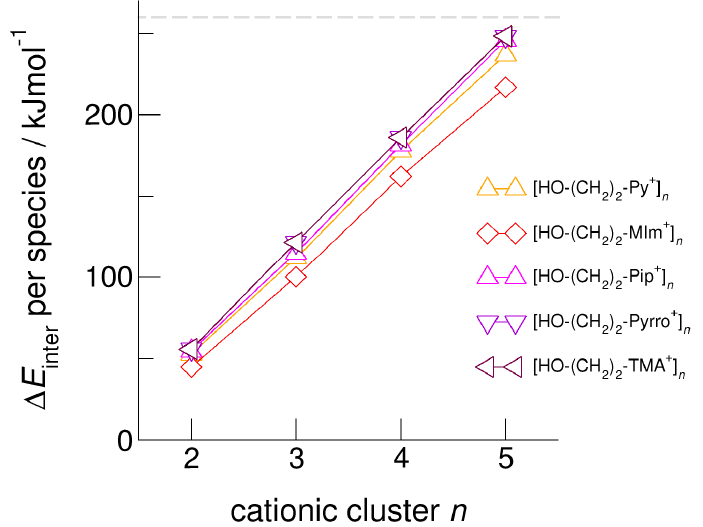
Figure 5. Intermolecular energies per species in the cationic clusters [HO-(CH 2 ) 2 -Py + ] n , [HO-(CH 2 ) 2 -MIm + ] n , [HO-(CH 2 ) 2 -Pip + ] n , [HO-(CH 2 ) 2 -Pyrro + ] n , and [HO-(CH 2 ) 2 -TMA + ] n calculated at the B3LYP-D3 / 6–31 + G* level of theory. The dashed grey line indicates meta-stability of the cationic clusters with energies below 260 kJ mol − 1 per cation. Beyond this energy, the cationic clusters undergo “Coulomb explosion” and dissociate [59].